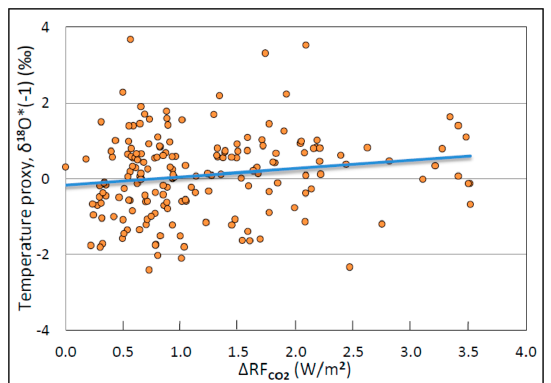
Figure 9. Scatter plot of detrended temperature-proxy data averaged in one-My bins from 425 to 0 My ago versus marginal RF by atmospheric CO 2 . The positive correlation coefficient ( R = 0.16, n = 199) is discernibly different from zero ( p = 0.02) at this large sample size, but weak, i.e., as Δ RF CO2 increased, the temperature proxy δ 18 O*( − 1) increased only slightly. The trendline was fitted by the method of least squares.